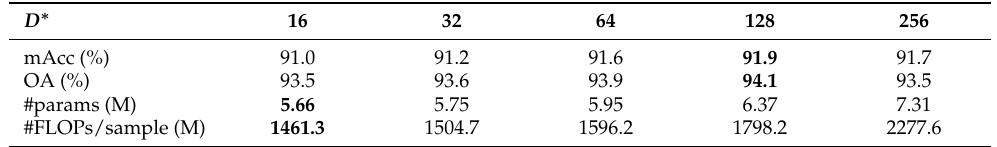
Table 5. Result and model complexity comparison with different dimensions of geometric feature fusion. The bolded text indicates the best